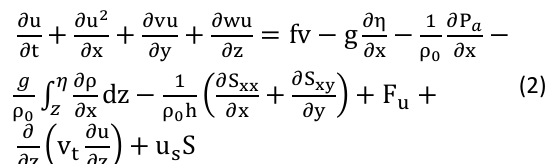
Fig. 1: Geographic location of the study area and station sampling in Misool, West Papua, Indonesia